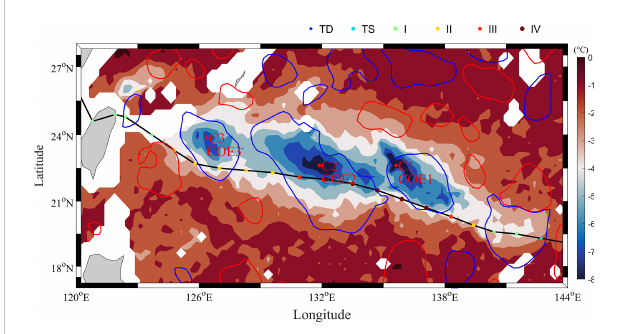
FIGURE 5 Spatial distribution of maximum sea surface cooling from remote sensing (color shading) during Typhoon Soulik and the preexisting mesoscale eddies on July 6 (blue and red contours). The blue (red) contours delineate the edges of the CEs and anticyclonic eddies. The red dots (C1, C2 and C3) are the cooling centers within the corresponding preexisting CEs (CE1, CE2 and CE3). The other symbols are the same as those in Figure